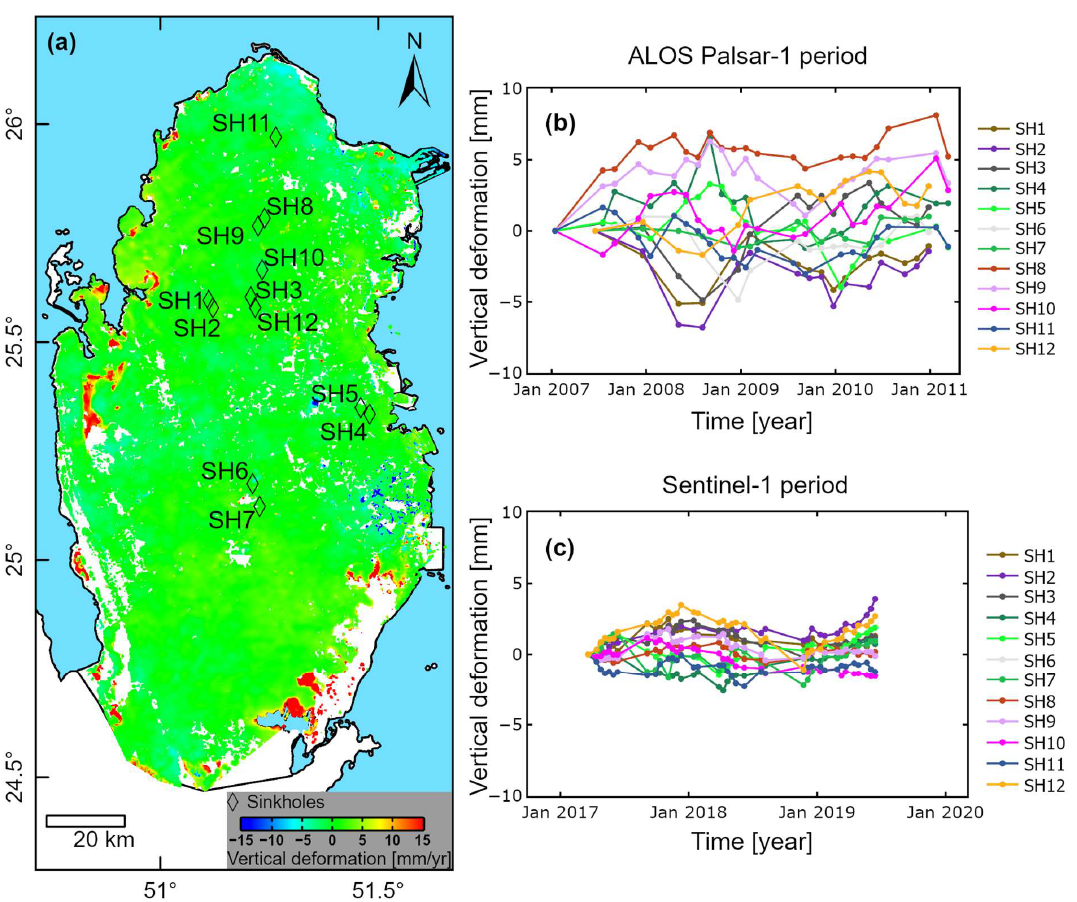
Figure 7. ( a ) Distribution of reported sinkholes over Qatar and deformation time series calculated over sinkholes using ( b ) ALOS Palsar-1 and ( c ) Sentinel-1 data.